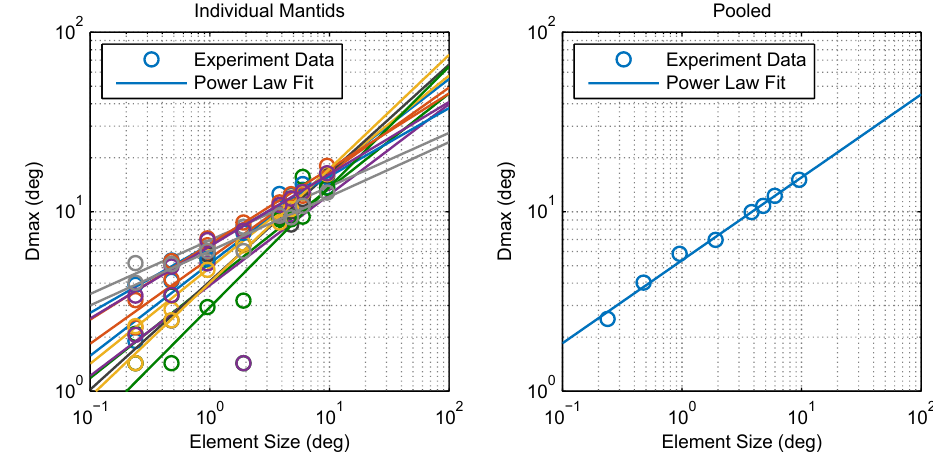
Figure 4. Relationship between Dmax and element size. Calculated Dmax values and power law fits for individual mantids ( left ) and pooled data ( right ). The points appear to lie on a straight line on this log-log plot indicating that Dmax can be described accurately as a power law function of element size x , determined via fitting as Dmax ( x ) = 5.36 × x 0.462 (standard error of the regression S = 0.318 ◦ ) for pooled data. Individual power law fits ( left ) had a mean S of 1.12 ◦ with σ = 0.714 ◦